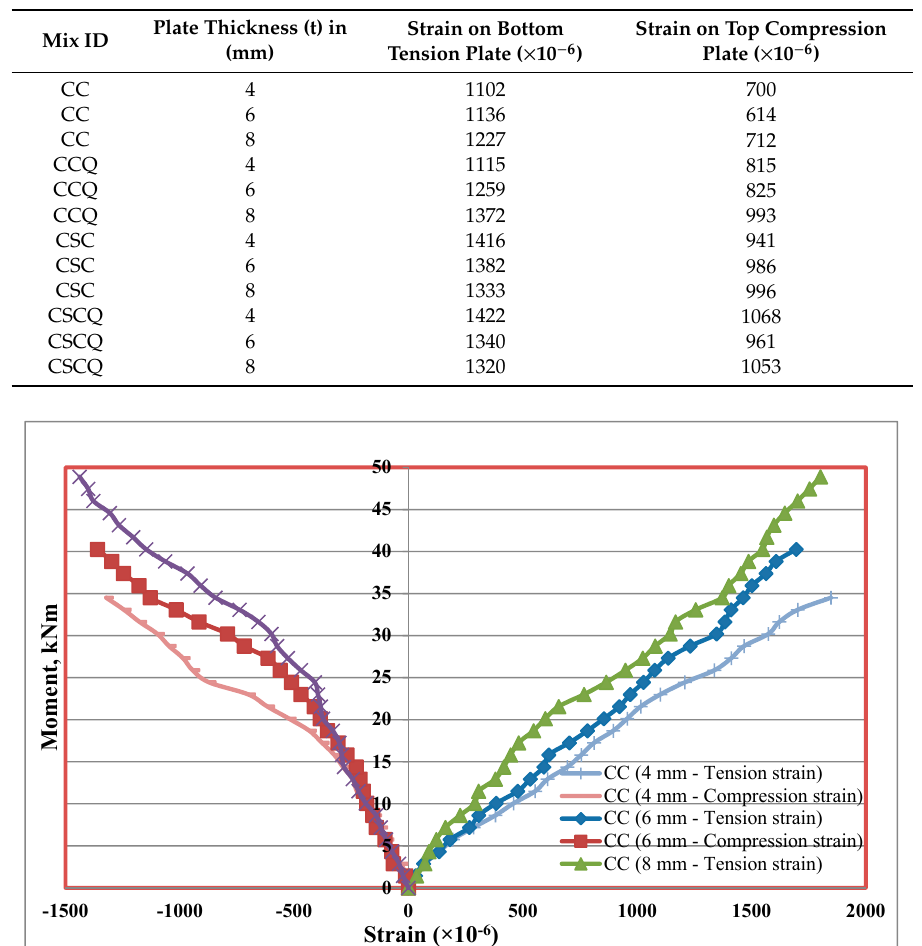
Table 8. Result of tension and compression steel plates’ strain of tested beams.